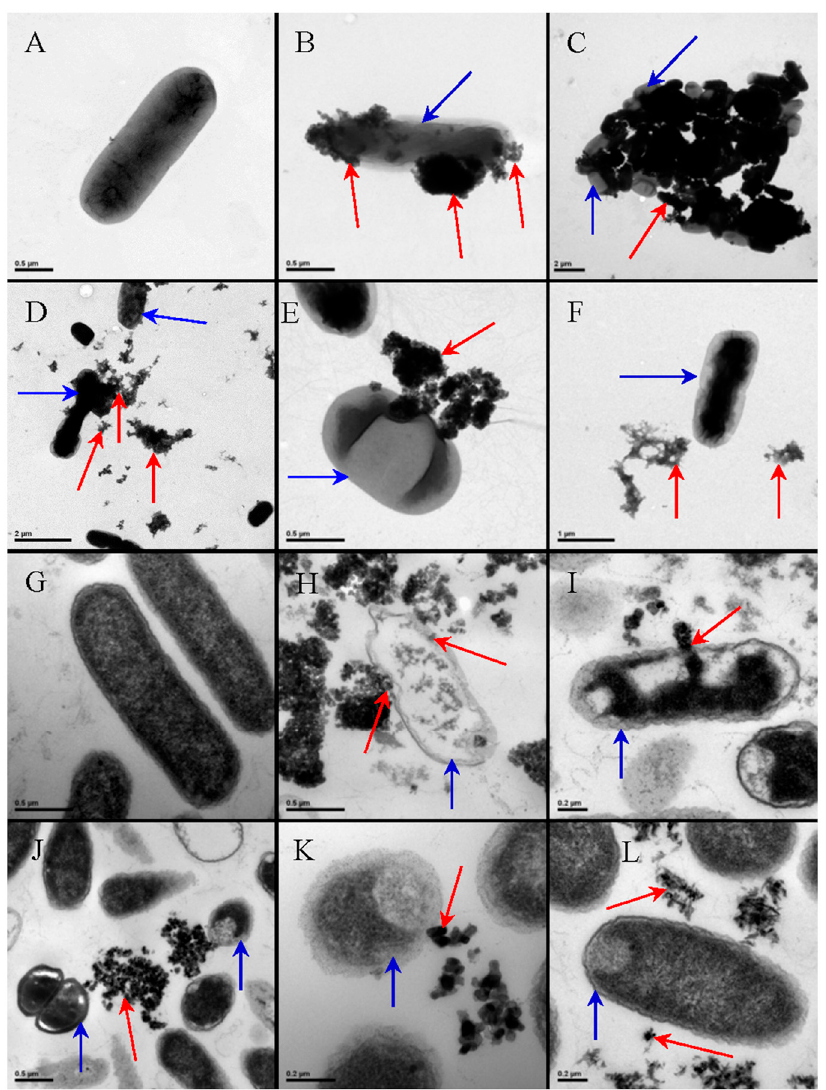
Figure 6. TEM images showed NPs-type-dependent bacterial cell membrane localizations of TiO 2 NPs and the morphological changes of the cell exposed to the NPs: TEM images of the unsliced ( A – F ) and sliced ( G – L ) Escherichia coli samples: A and G untreated; B and H upon treatment with 10 nm anatase TiO 2 NPs; C and I upon treatment with 25 nm anatase TiO 2 NPs; D and J upon treatment with 50 nm anatase TiO 2 NPs; F and L upon treatment with 50 nm rutile TiO 2 NPs; with all samples having been exposed to natural sunlight. The blue arrows highlight the cells and the red arrows point to the NP aggregates. Reprinted with permission from ref